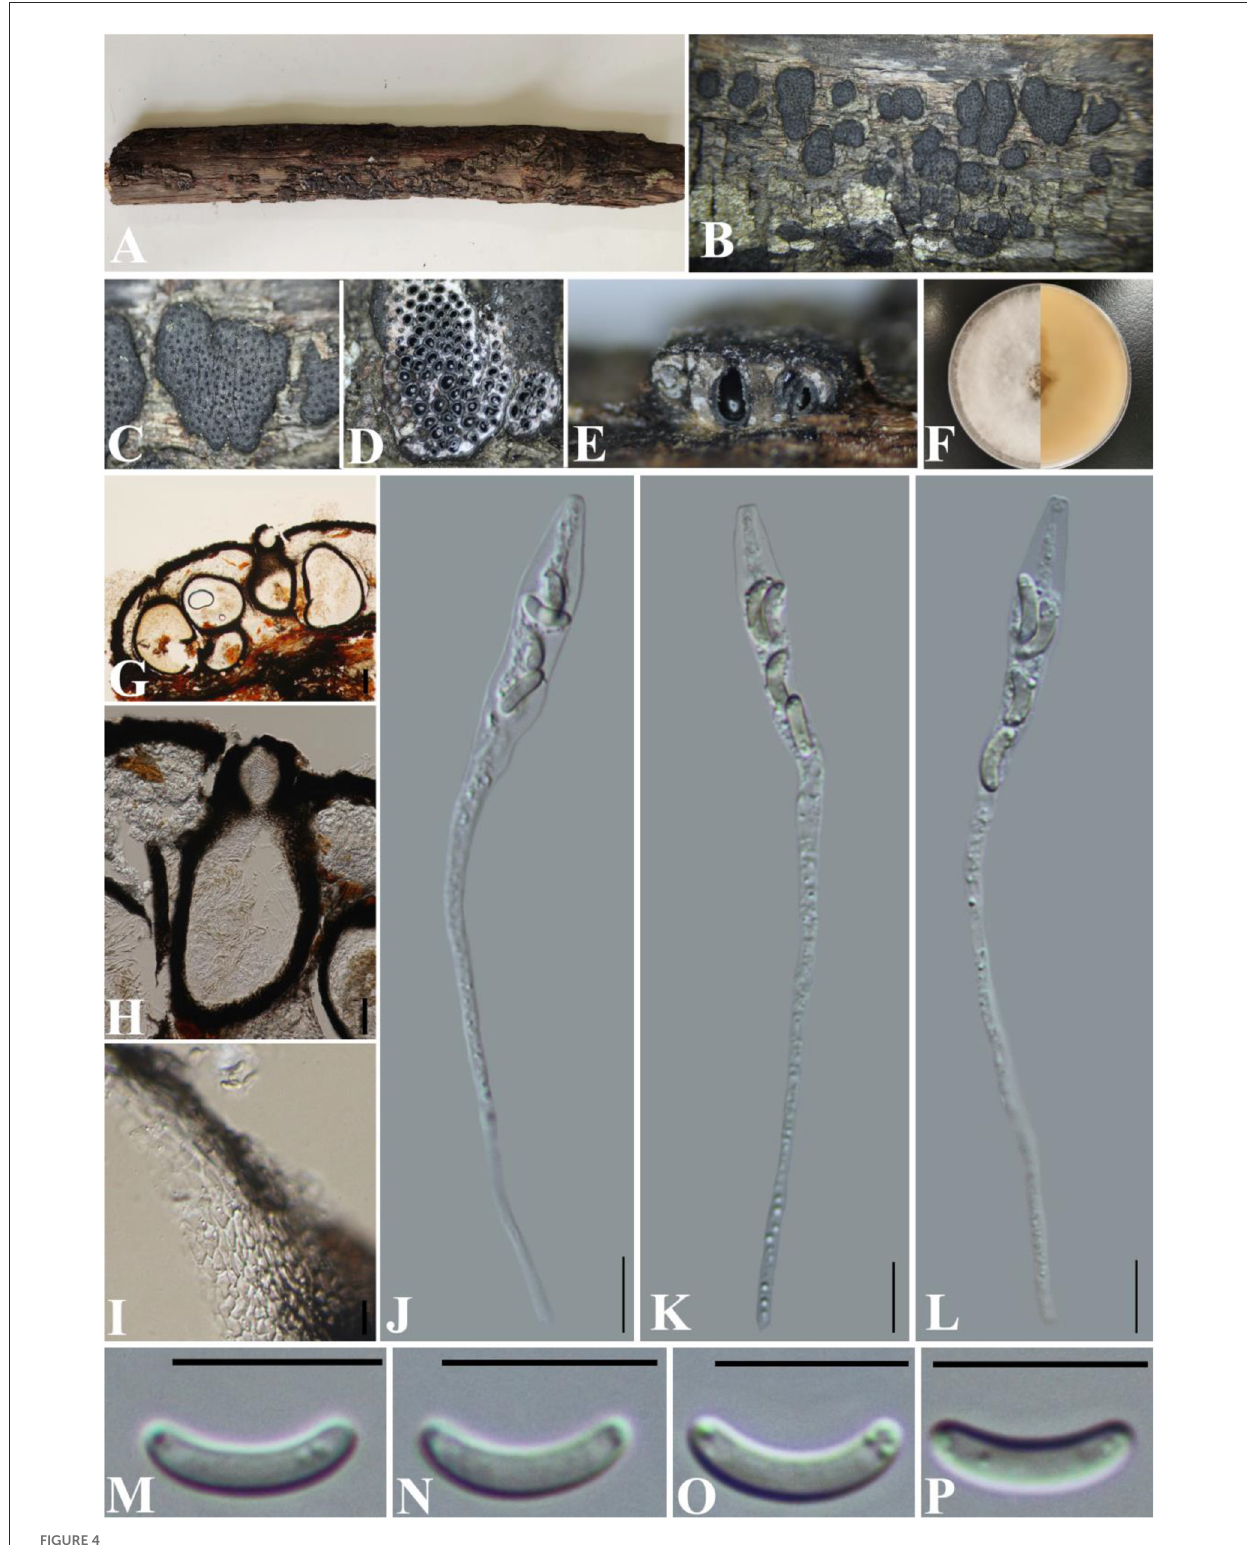
FIGURE4 Diatyrpe betulae (GMB0426). (A) Material. (B, C) Close-up of stromata. (D) Transverse section through stromata. (E) Vertical section through stromata. (F) Culture on PDA. (G) Section through the ascostroma. (H) Ostiolar canal. (I) Peridium. (J–L) Asci. (M–P) Ascospores. Scale bars: (G) = 50 µ m; (H–P) = 10 µ